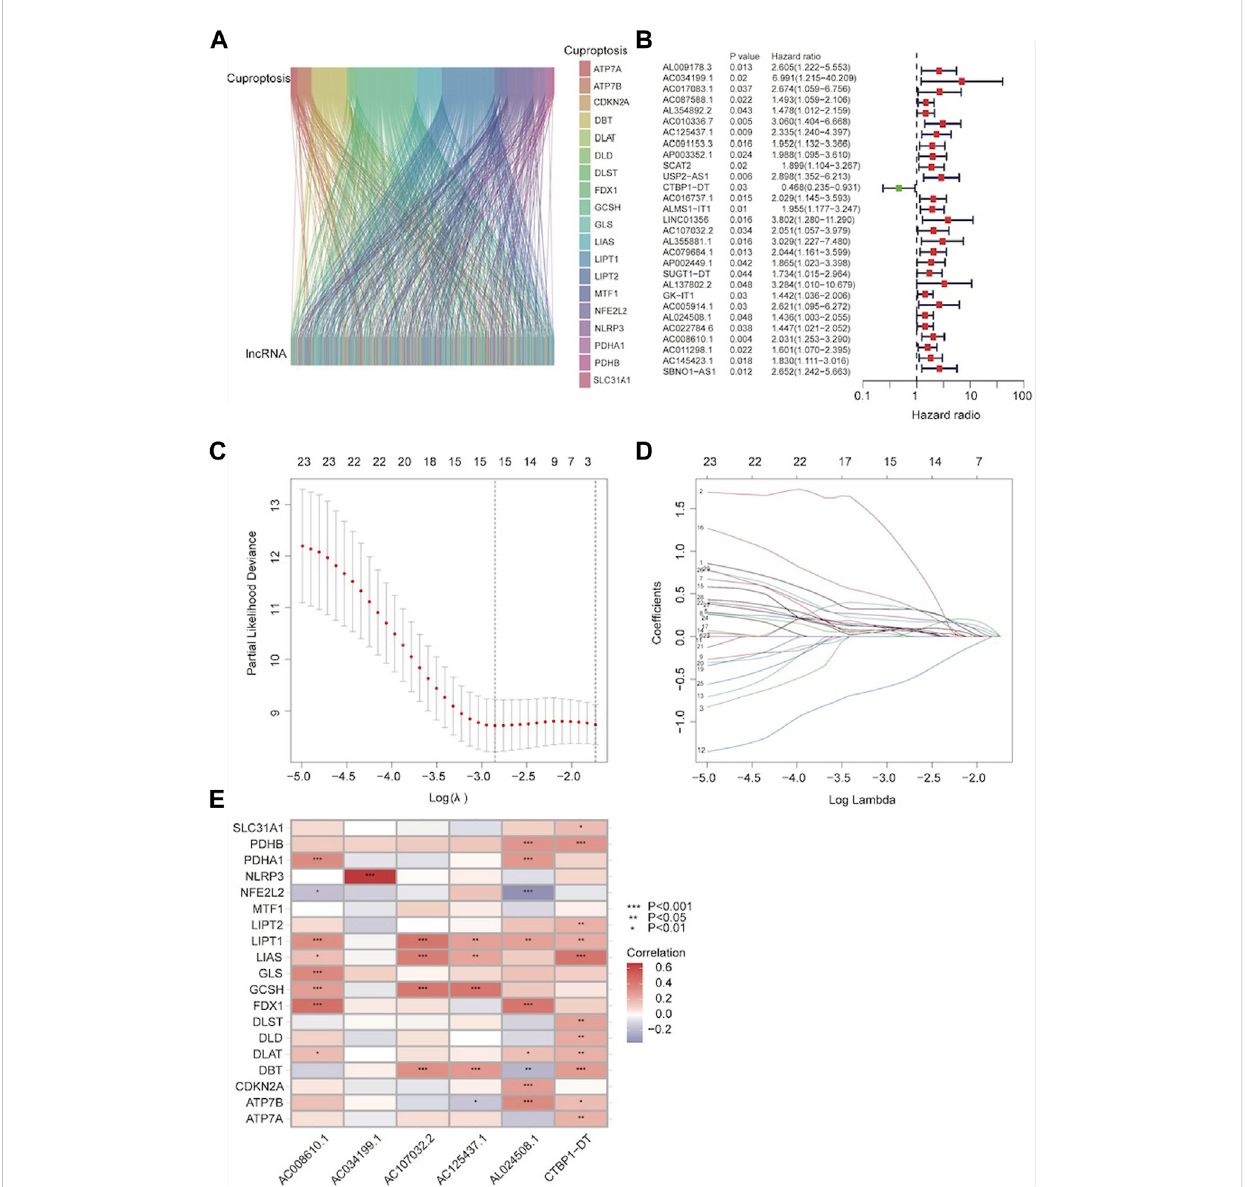
FIGURE 1 Identi fi cationofthecuproptosis-relatedlncRNAs(CRLs). (A) Co-expressionoflncRNAandcuproptosis-relatedgenes. (B) Theforestmapshowsthe lncRNA of different risk groups; red represents high-risk lncRNAs and green represents low-risk lncRNAs. (C) A general cross-validation curve of the paired likelihood deviance. (D) LASSO coef fi cients of prognostic genes. (E) A correlation heatmap revealed the association between CRLs and cuproptosis-related genes. Positive correlations are shown in red while negative correlations are represented in